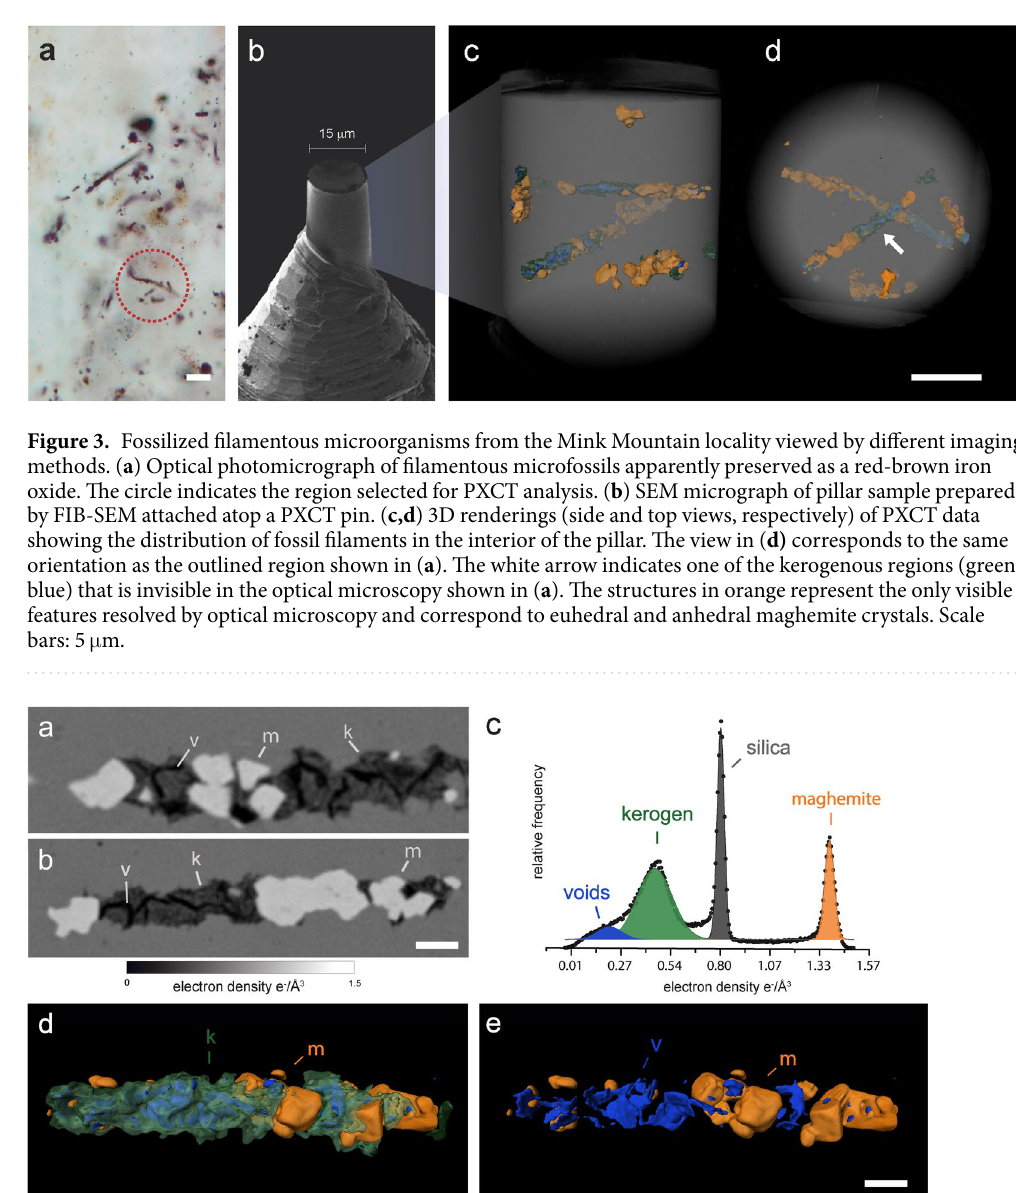
Mink mountain locality samples.